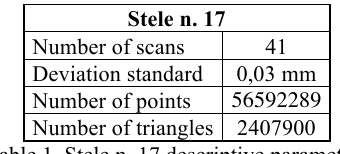
Table 1. Stele n. 17 descriptive parameters